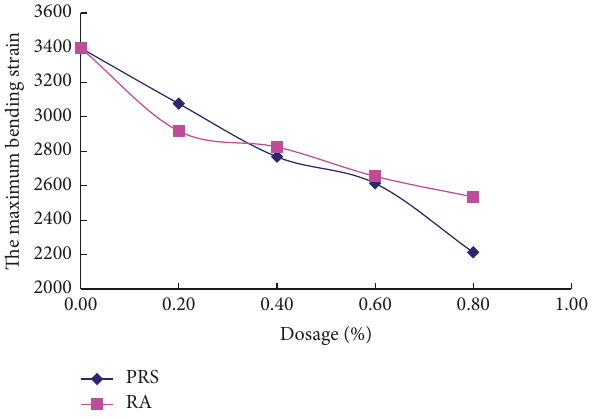
Figure 11: The maximum flexure tensile strain of asphalt mixture with different dosage of additive.